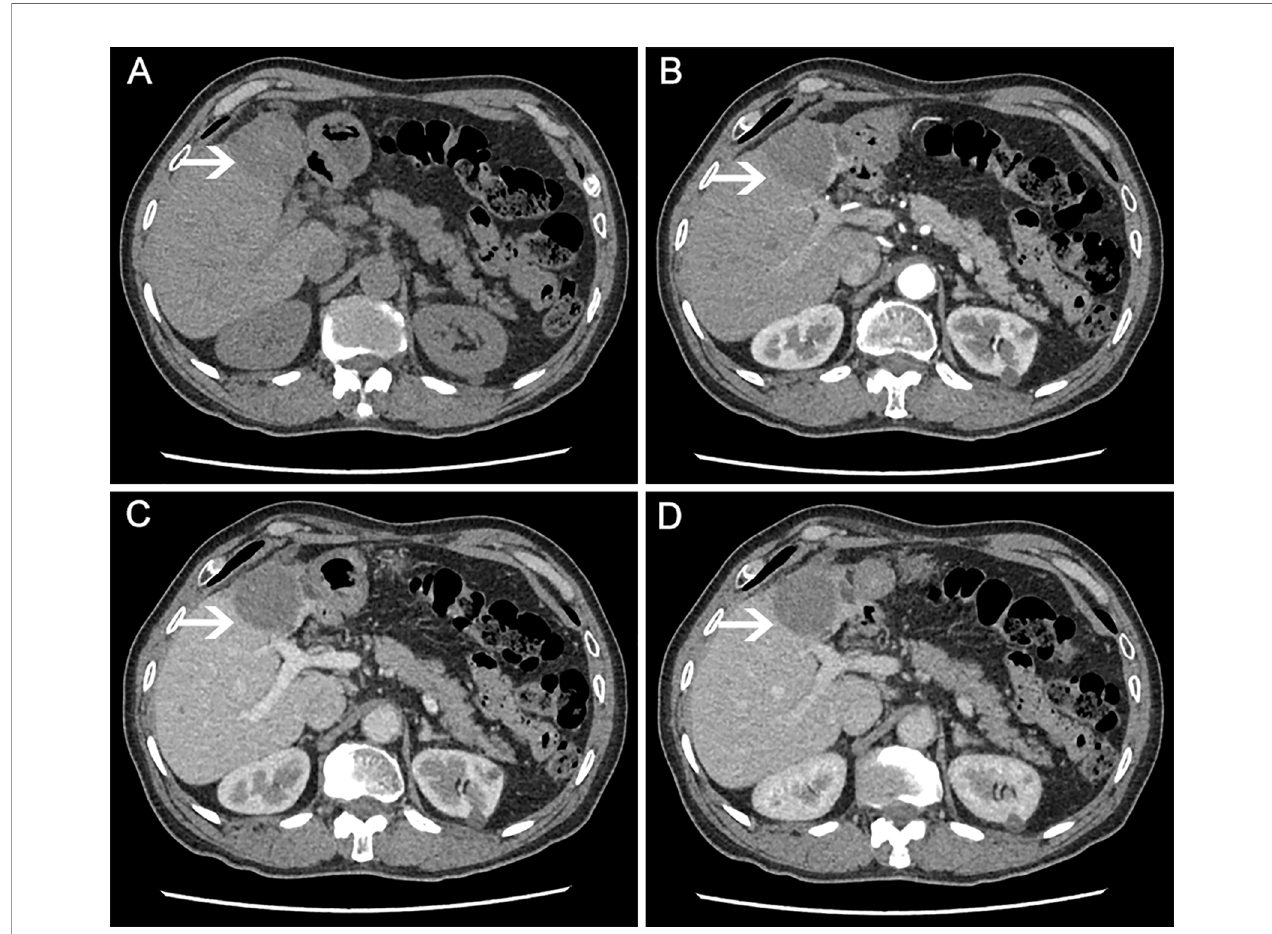
FIGURE 3 | CT scan (on January 21, 2021) showing liver mass after 48 months of apatinib treatment. (A) plain scan; (B) arterial phase; (C) venous phase; (D) equilibrium